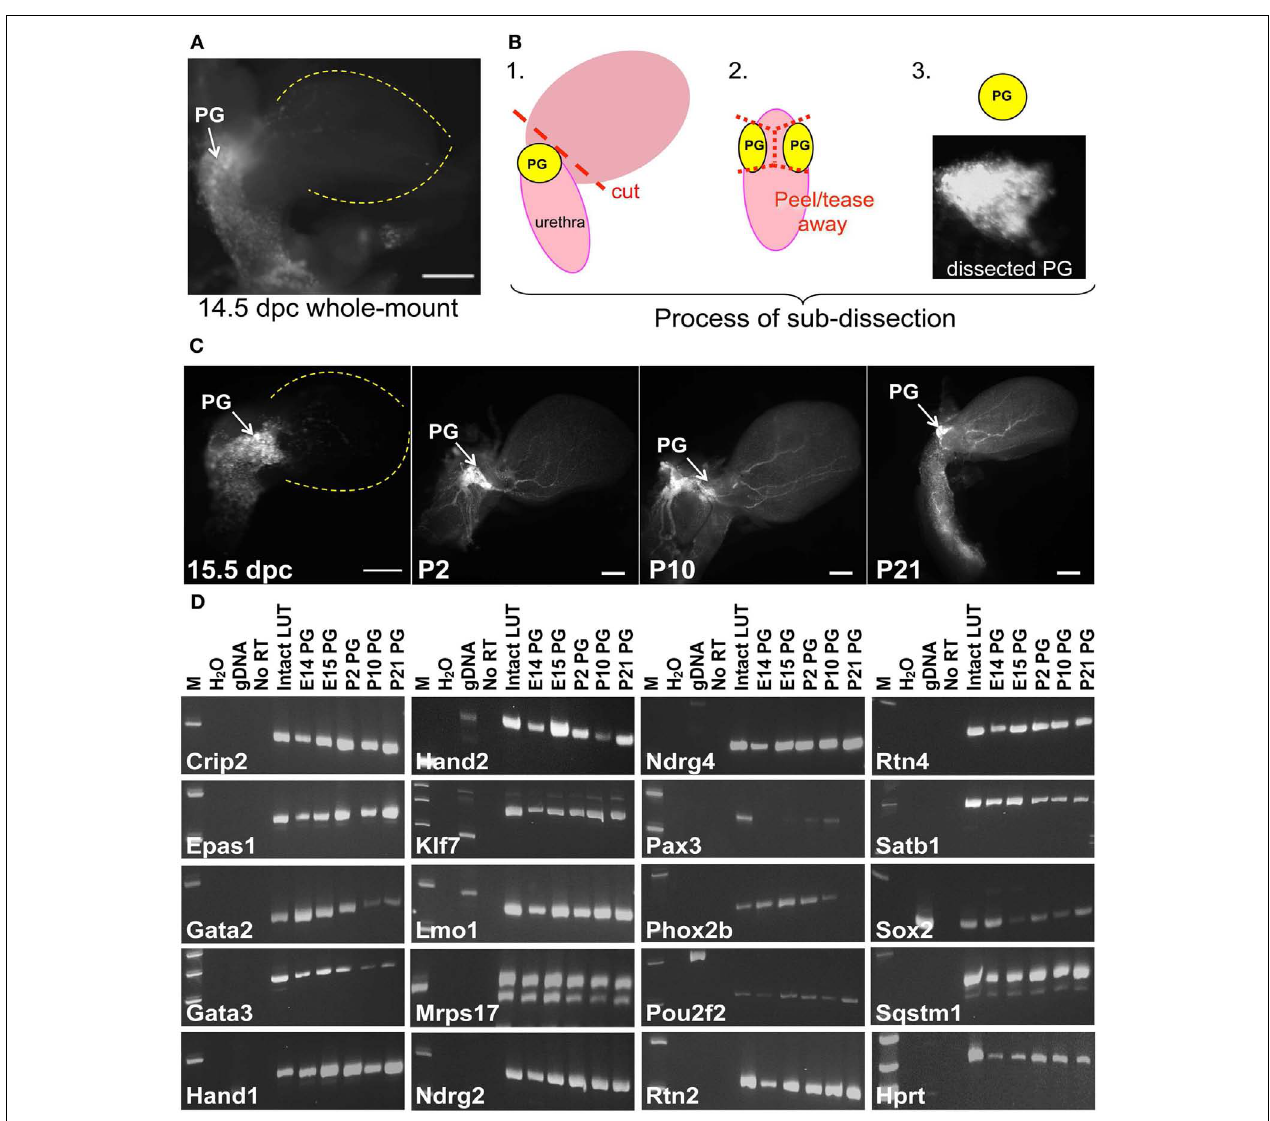
bar = 1000 µ m. (D) Gel electrophoresis images of RT-PCR products relative to a standard molecular weight marker identifies individual genes expressed in fetal development and post-natal maturation of pelvic ganglia. Sample order: no template water control, genomic DNA control, no RT control (15.5dpc RNA sample), 15.5dpc intact LUT (consisting of distal ureter, bladder, urethra, pelvic ganglia, and genital tubercle) and Sox10 -H2BVenus pelvic ganglia RNA isolates harvested at 14.5dpc, 15.5dpc, P2, P10, and P21. A housekeeping control gene ( Hprt ) is included for